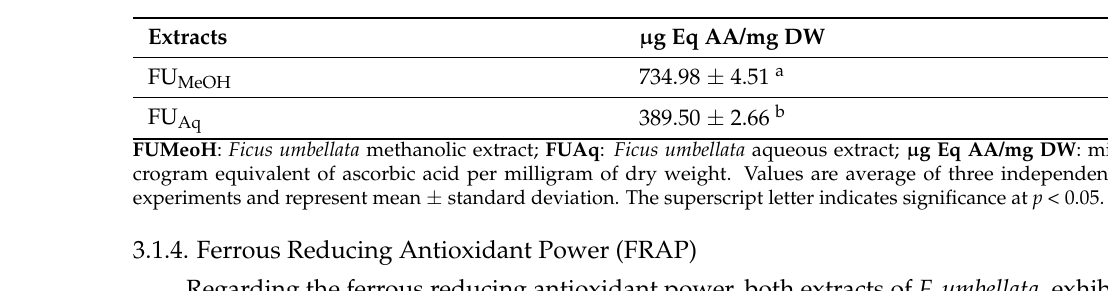
Table 3. Total antioxidant capacity of F. umbellata extracts.